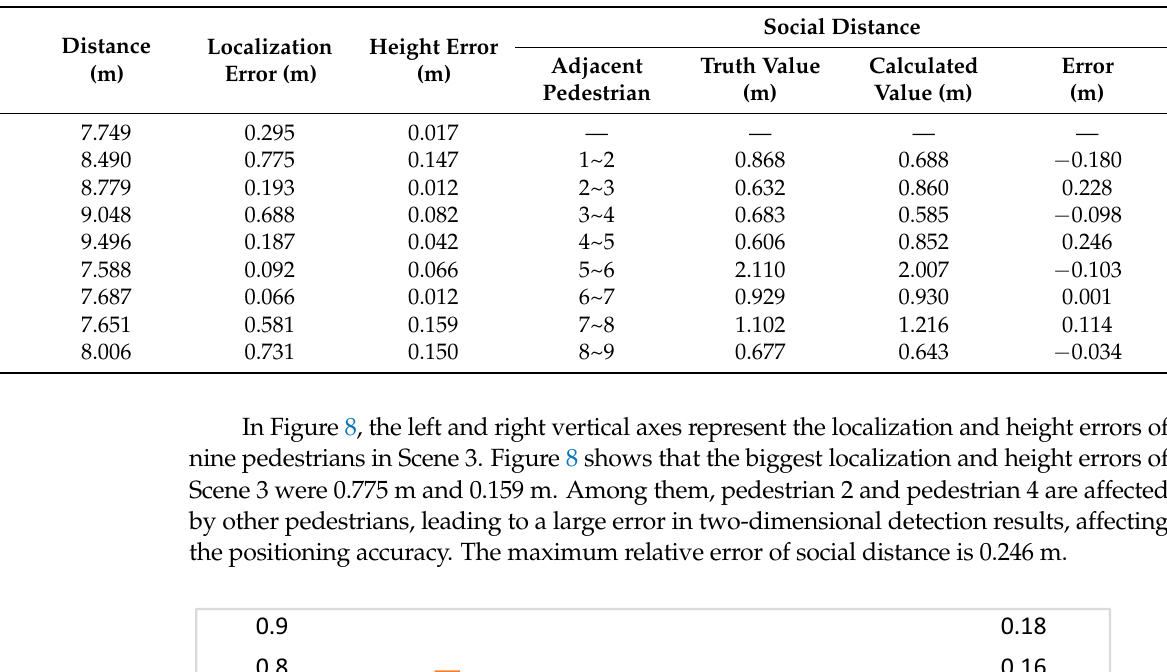
Figure 7. Scene 3 and pedestrian localization results. Table 4. Pedestrian localization and height errors of Scene 3 in KITTI.